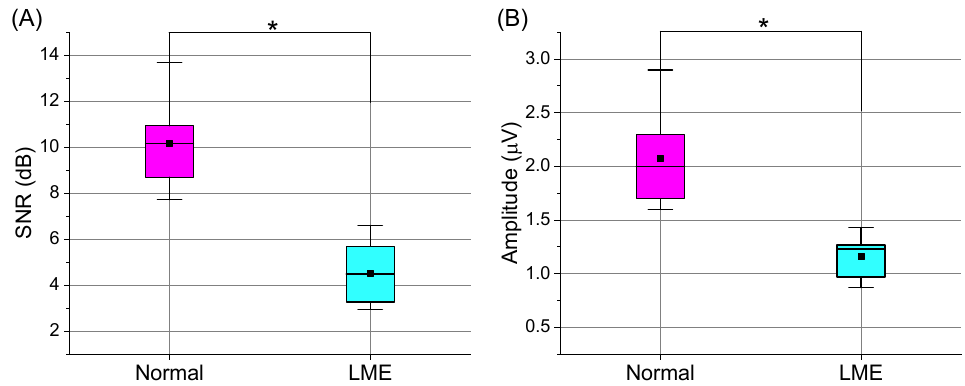
Figure 6. Amplitudes and SNRs in the Normal and LME Conditions. We plotted this figure using the EEG signals collected in the online phase of the normal and LME condition experiments. The subfigures ( A , B ) showed the amplitudes and SNRs of the collected EEG signals, respectively. In this figure, “*” means that the results were significantly different ( p < 0.001).